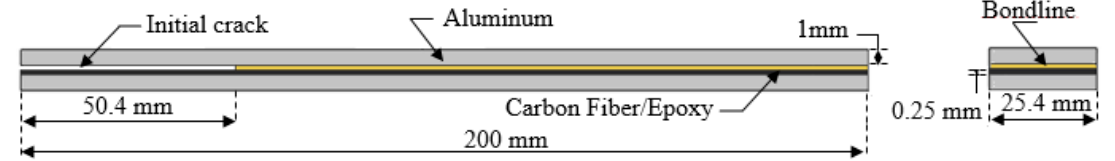
Figure 9. Schematic of the T-peel specimen along with the dimensions (mm).